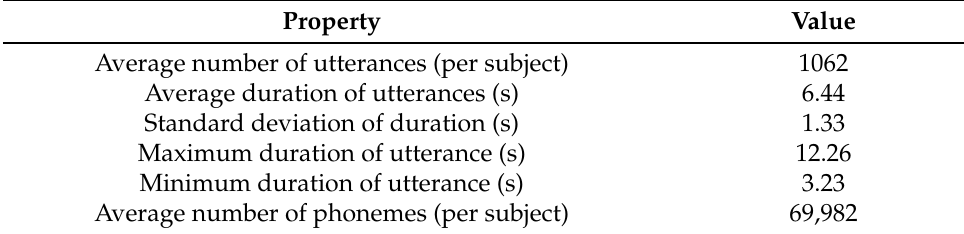
Table 3. Dataset